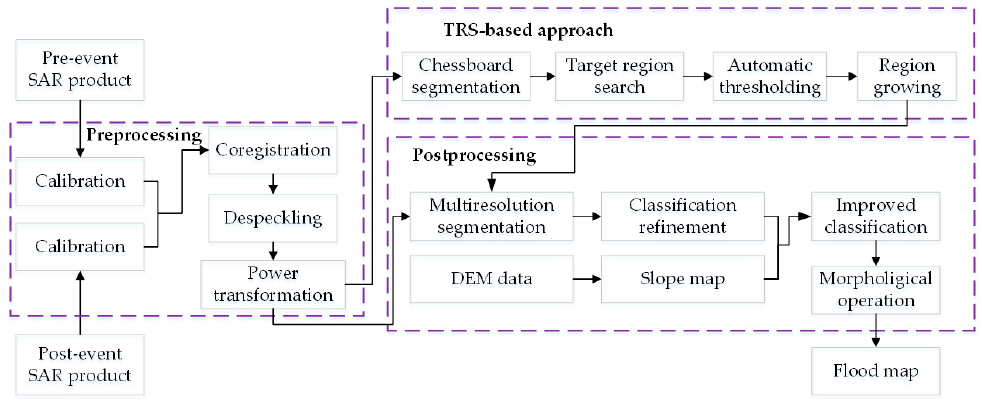
Figure 2. The proposed framework for large-scale flood detection. TRS: target region search.